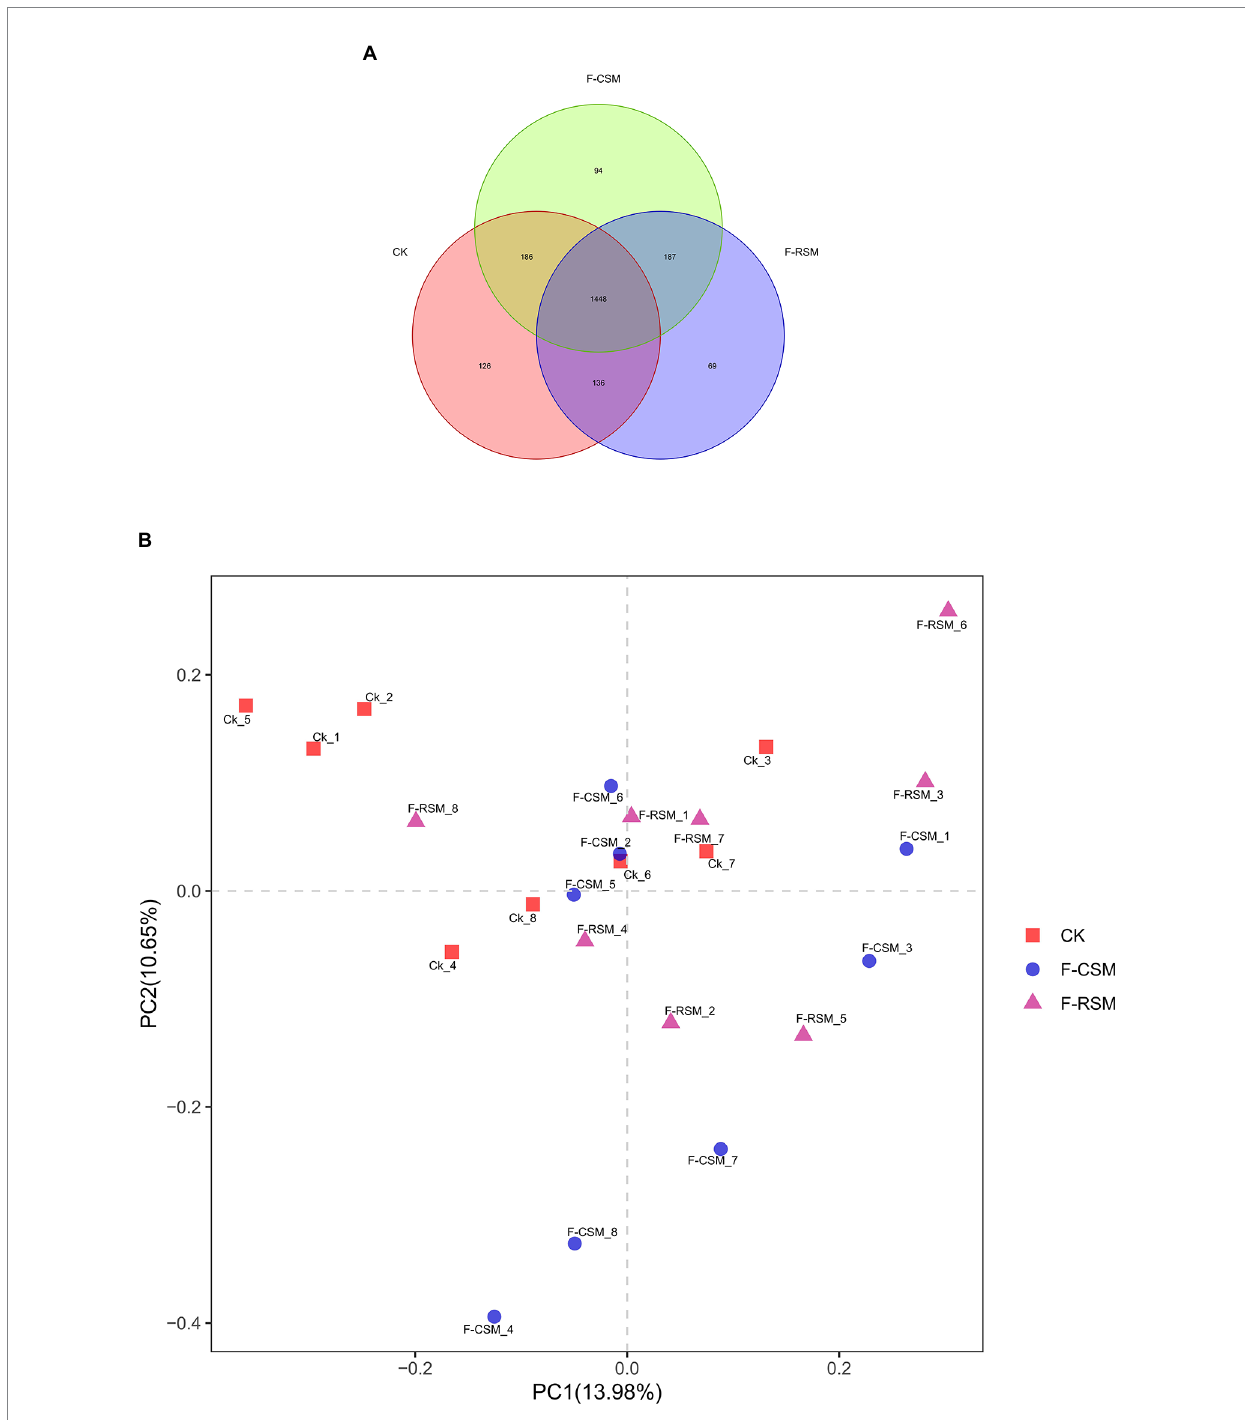
FIGURE 1 Effects of the diets on rumen microbiota of Hu sheep (A) Composition of rumen microbiota from Hu sheep fed three diets (OTU-level analysis). (B) PCoA analysis of rumen microbiota from Hu sheep fed different diets (%); CK, non-fermented group; F-CSM, fermented cotton seed meal TMR; F-RSM, fermented rapeseed meal